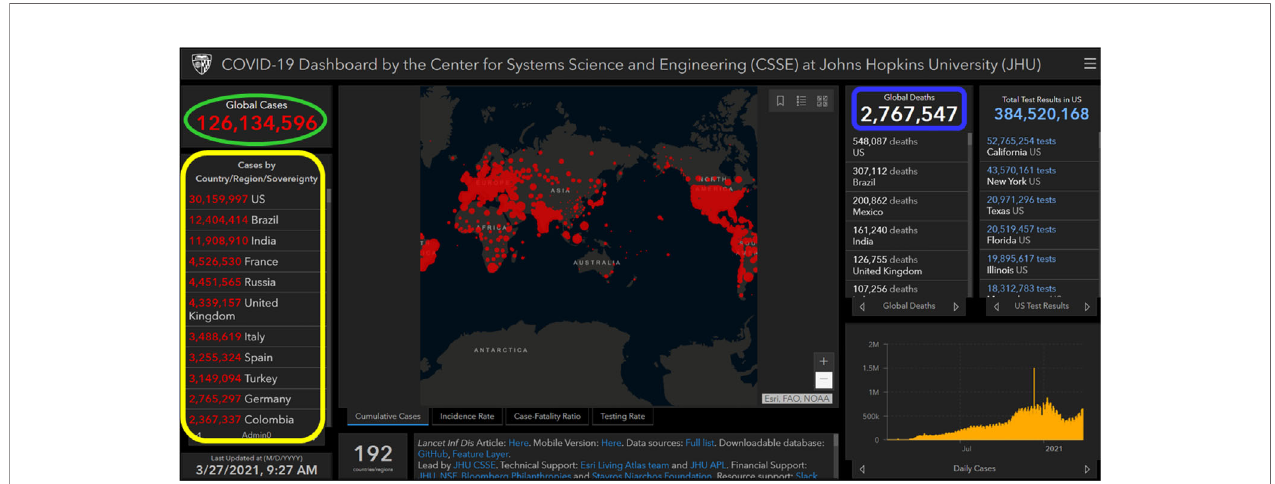
FIGURE 3 | Image showing a screenshot as of 27 March 2021 (9:27 AM) of a collective global map of COVID-19 cases by the Center for Systems Science and Engineering, Johns Hopkins University, United States (37). This database is updated constantly and can be viewed at https://www.arcgis.com/apps/opsdashboard/ index.html#/bda7594740fd40299423467b48e9ecf6. On the left-hand side, region/country showing nine most infected COVID-19 cases (circled in yellow color), on the top left-hand side global infected cases are showing (circled in green color), and on the top right-hand side global deaths are showing (circled in blue color).